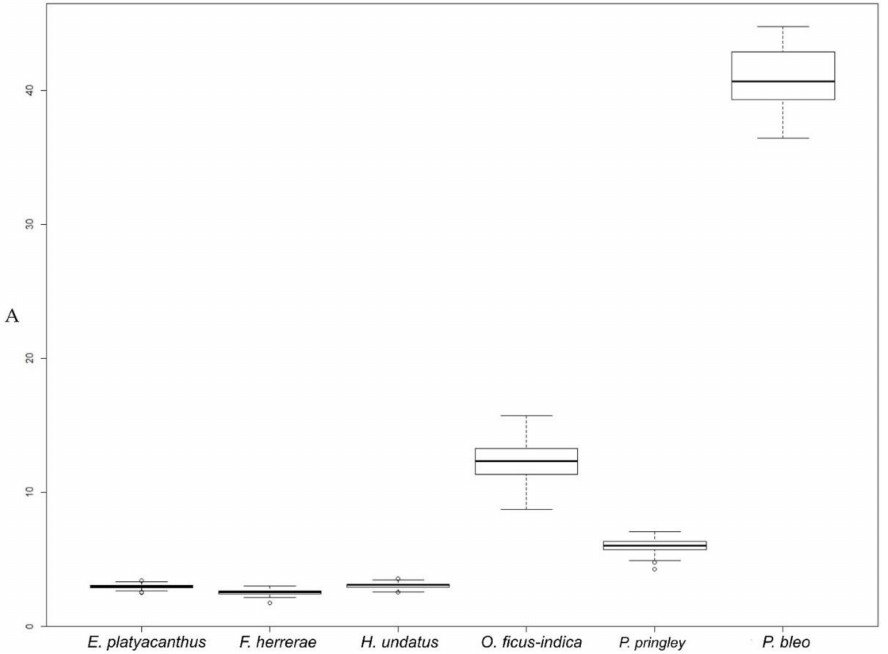
Figure A1. Values of area for seeds of the species Echinocactus platyacanthus , Ferocactus herrerae ,